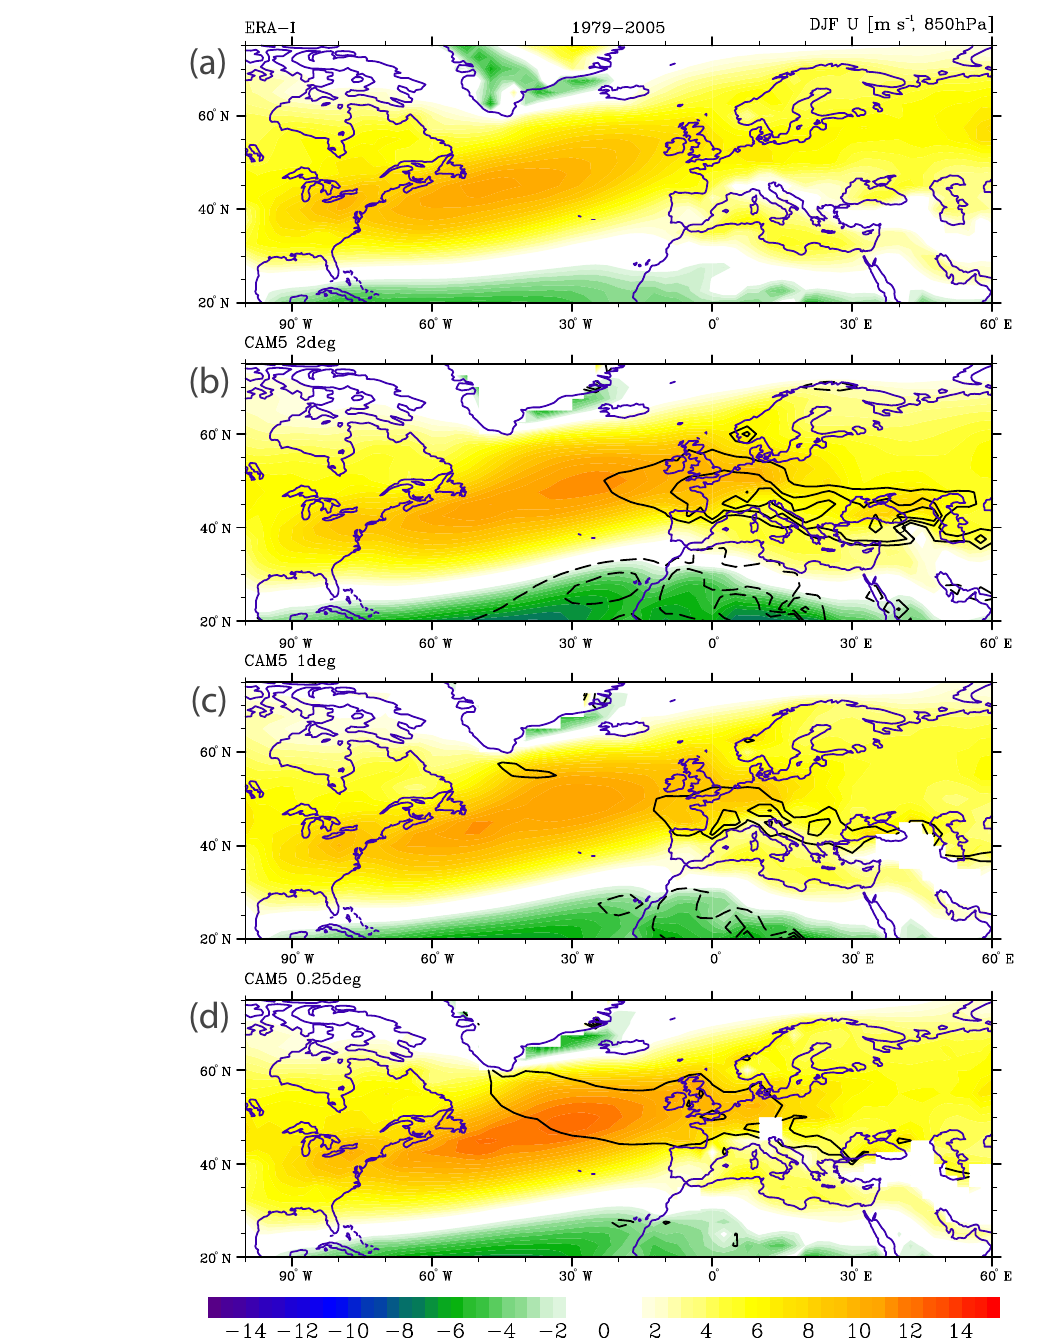
Figure 2. Time-mean average of the DJF zonal wind (ms − 1 ) over the period 1979–2005, regridded to a 2.5 ◦ × 2.5 ◦ horizontal grid for ERA- Interim (ERA-I, ∼ 0.75 ◦ lat–long original resolution), and CAM5 at ∼ 2 ◦ (CAM5_2deg), ∼ 1 ◦ (CAM5_1deg) and ∼ 0.25 ◦ (CAM5_0.25deg) lat–long resolution. Contours show the difference, in reference to